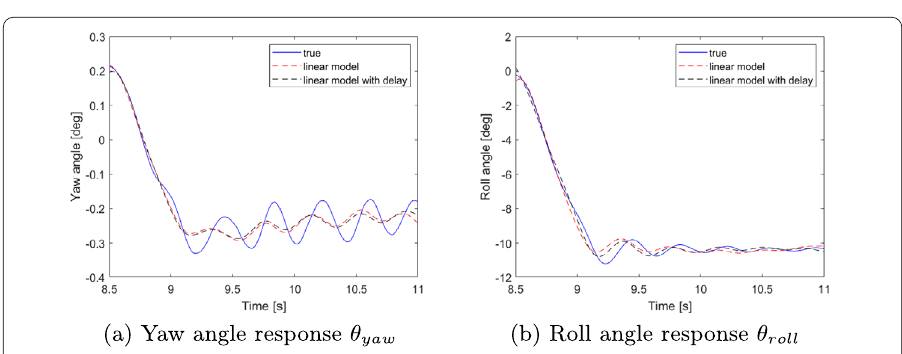
Figure 27 Yaw and roll angle responses against the identified linear model with delay